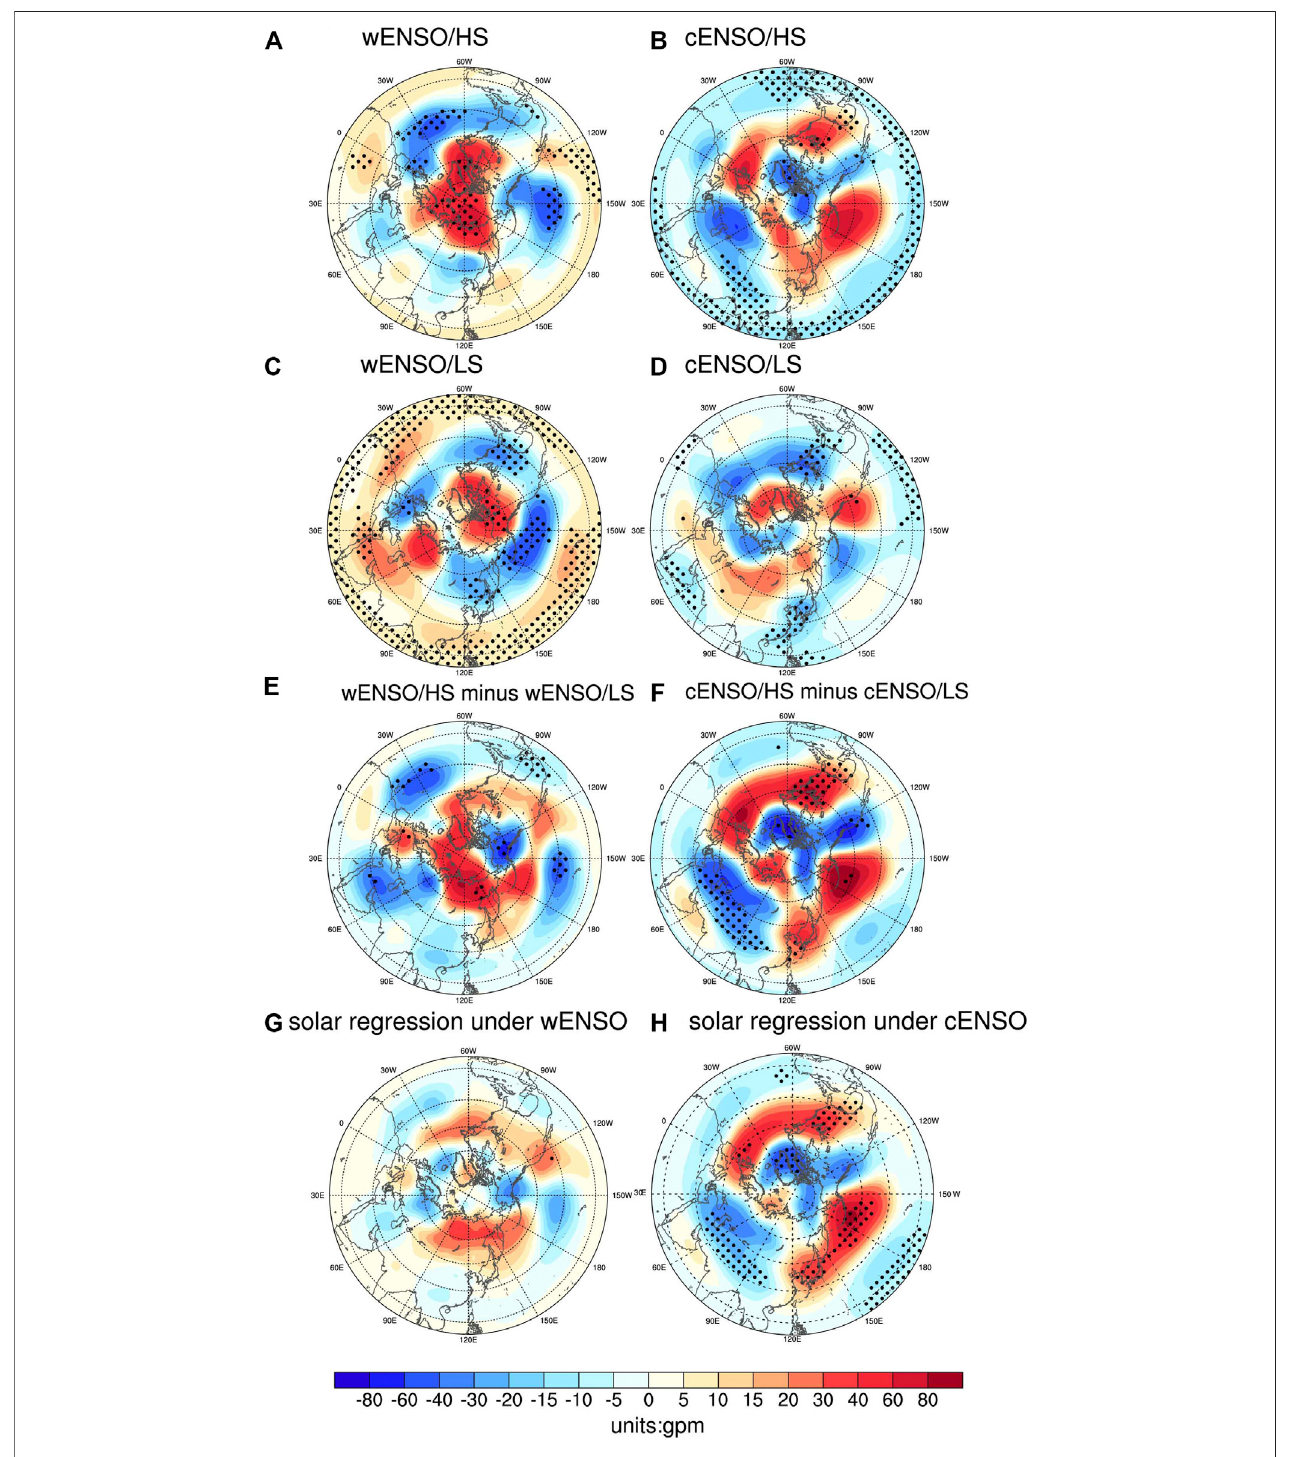
FIGURE 7 | Similar as Figure 6 , but for composites of geopotential height anomaly at 500 hPa (unit:gpm).